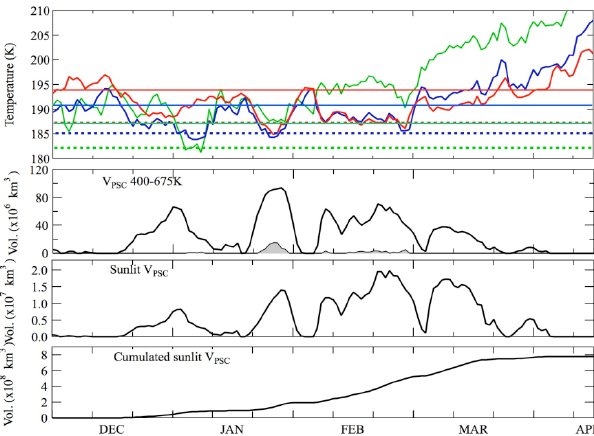
Figure 6. O Loss and vortex sunlit weighted PSC cumulated volume calculated for T 3 (green), T (black) and T +3K (blue) normalised on March 30. NAT NAT